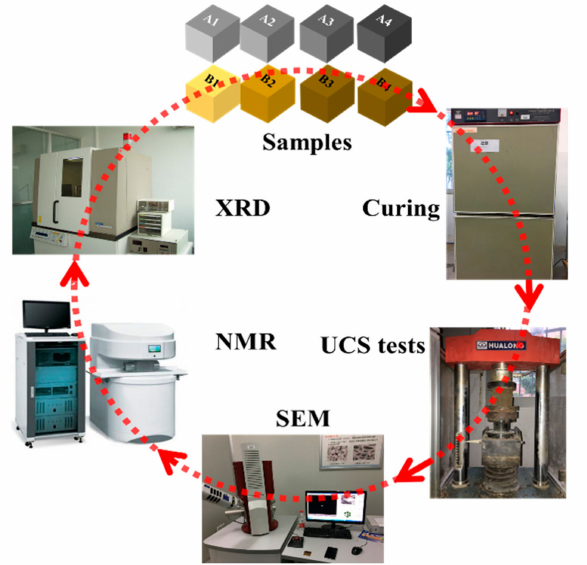
Figure 2. Experimental process with sample preparation, nuclear magnetic resonance (NMR) experiment, uniaxial compressive strength (UCS) tests, and scanning electron microscope